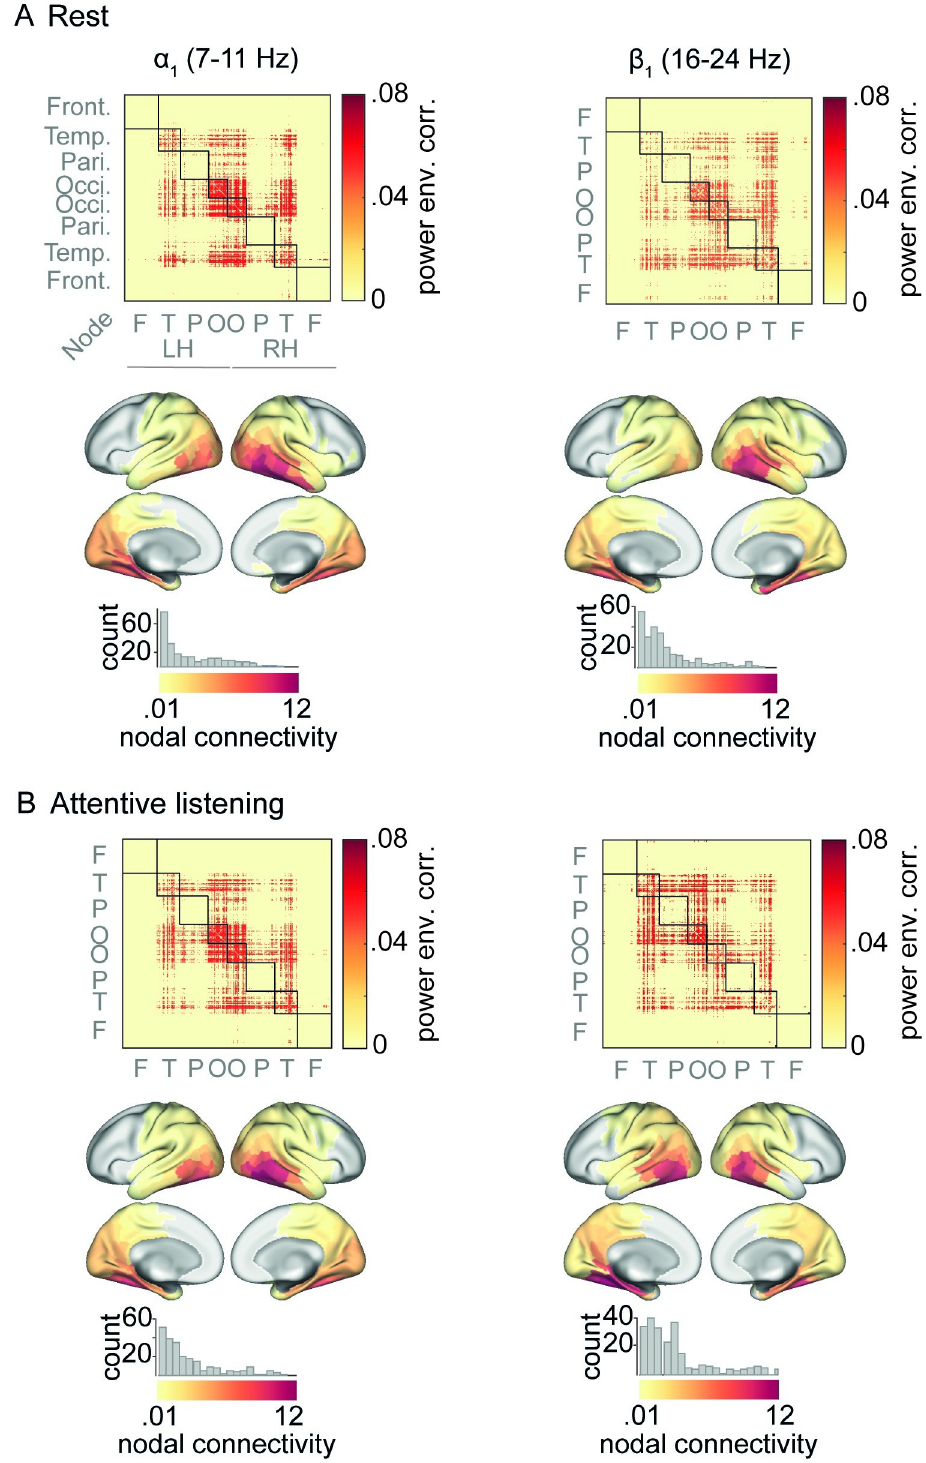
Fig 4. Connectivity maps of α / β oscillations under rest and attentive listening. (A) For each frequency band, power-envelope correlations between EEG oscillatory sources were estimated using 5-min eyes-open resting state data. (B) The same procedure as in (A) was applied to task data after concatenating whole-trial signals across 30 random trials of each block (5-min data in total as in rest), and then averaging the correlation matrices across all 6 blocks